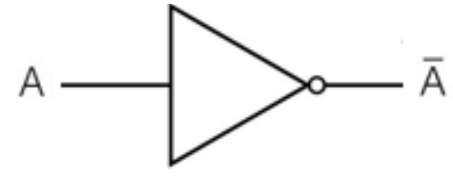
Figure 10. Classical NOT gate.